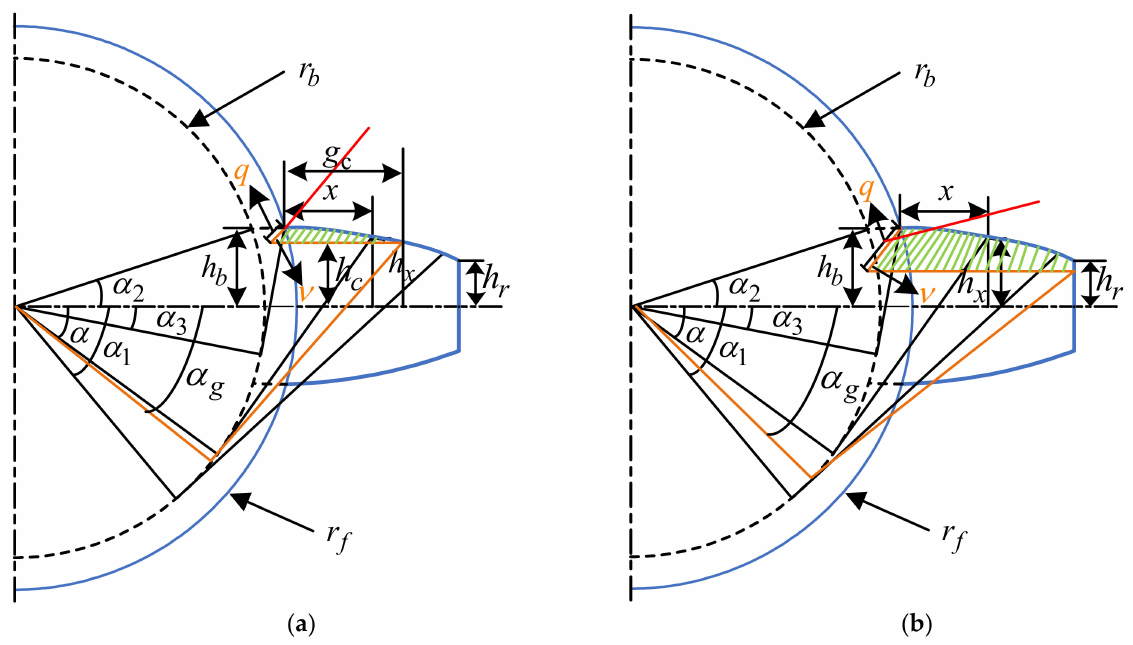
Figure 4. Crack tooth cantilever beam model: ( a ) Model of a tooth cantilever beam with shallow crack; ( b ) Model of tooth cantilever beam with deep